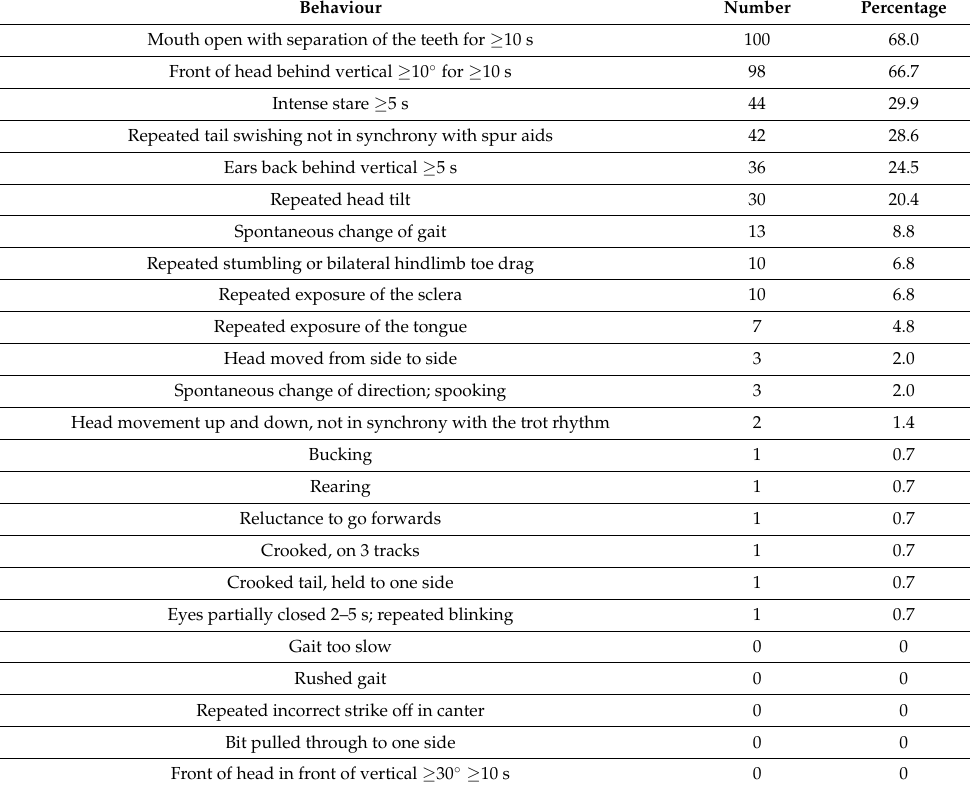
Table 4. Summary of the frequency of occurrence of each of the behaviours ( n = 24) of the Ridden Horse Pain Ethogram for all venues combined, for competitors ( n = 147) at World Cup Grand Prix Dressage Western League qualifying competitions ( n =7) and finals ( n = 2).